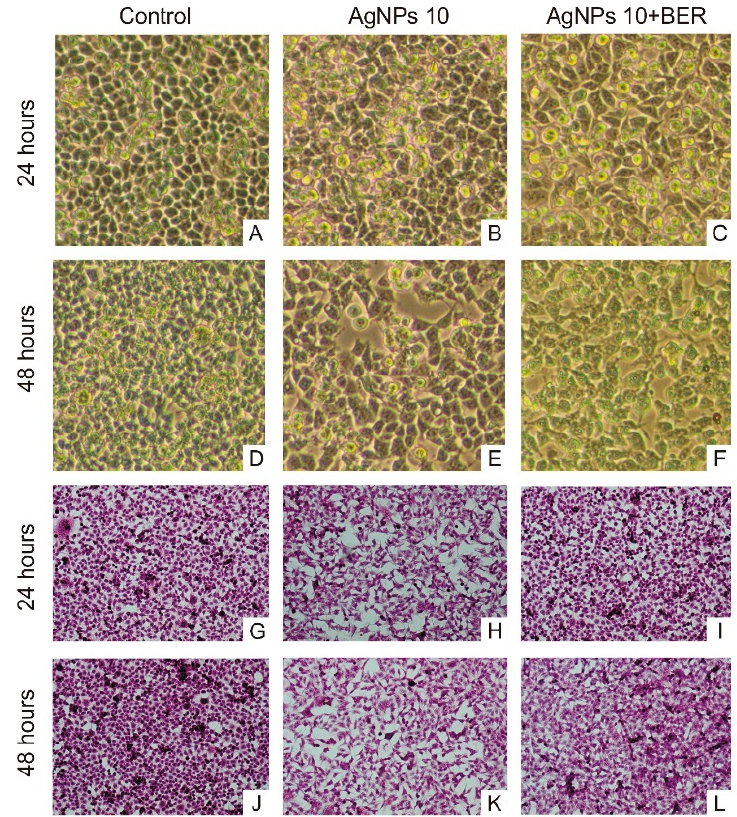
Figure 7 . Microscopic images (magnification 10 × 10) of untreated SCC-25 cells and ones treated with Figure 7. Microscopic images (magnification 10 ˆ 10) of untreated SCC-25 cells and ones treated 10 μ g/mL AgNPs and 10 μ g/mL AgNPs with 12.5 μ g/mL BER (1/2 IC 50 BER concentration). ( A – F ) with 10 µ g/mL AgNPs and 10 µ g/mL AgNPs with 12.5 µ g/mL BER (1/2 IC 50 BER